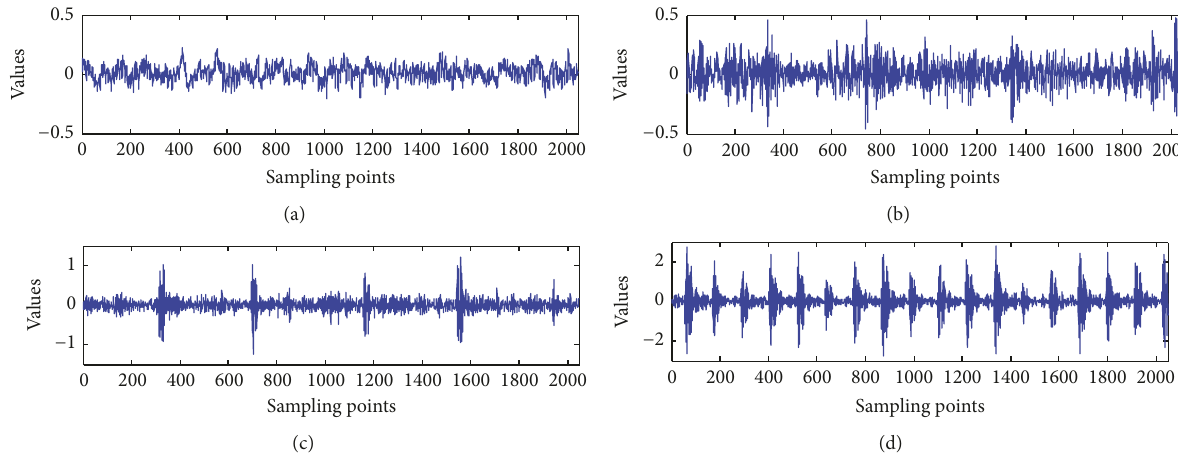
Figure 7: Signal collected from WSN of (a) normal status, (b) rolling bearing fault, (c) inner ring fault, and (d) outer ring fault.